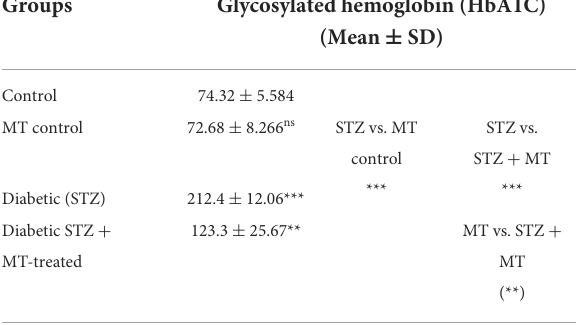
TABLE 3 Comparison of cumulative blood sugar values (HbA1C) between experimental groups in the STZ DM model.